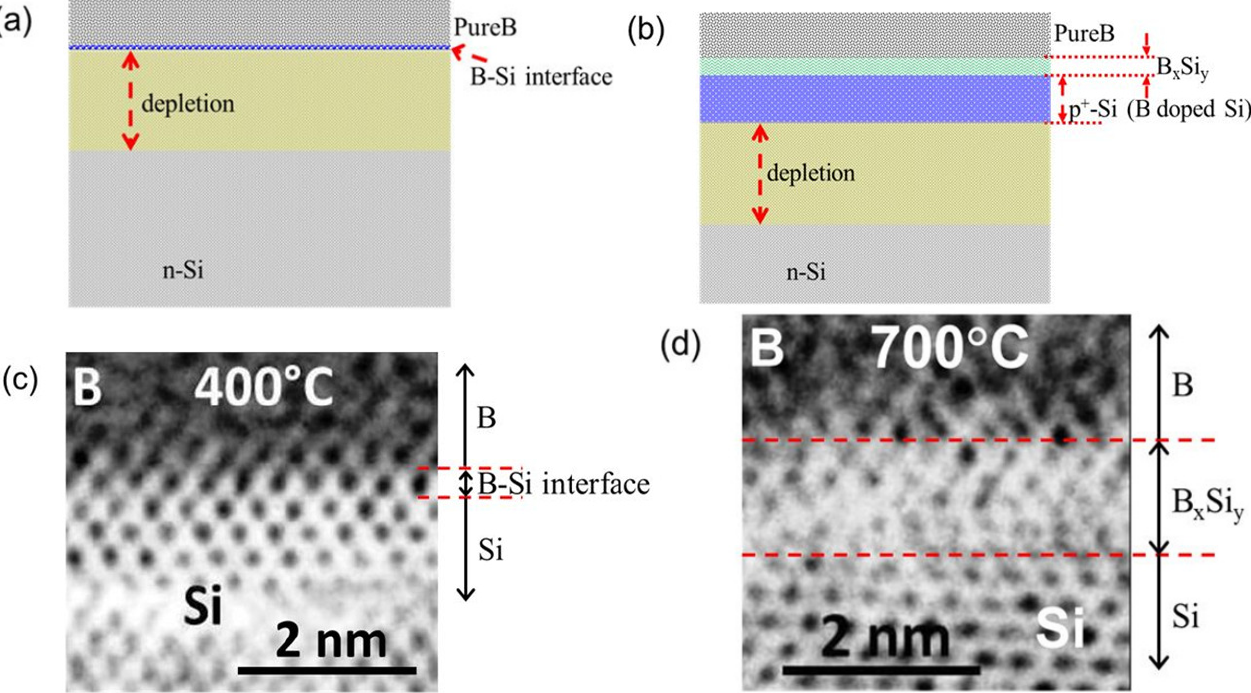
Figure 1. Schematic illustrations and High-Resolution Tunneling Electron Microscope (HRTEM) images of the cross-section of the layer stack: ( a ) schematic illustration of the cross-section of the B-Si junction processed at 400 ◦ C; ( b ) Schematic illustration of the cross-section of the B-Si junction processed at 700 ◦ C; ( c ) HRTEM image of the cross-section of the B-Si junction processed at 400 ◦ C; ( d ) HRTEM image of the cross-section of the B-Si junction processed at 700 ◦ C